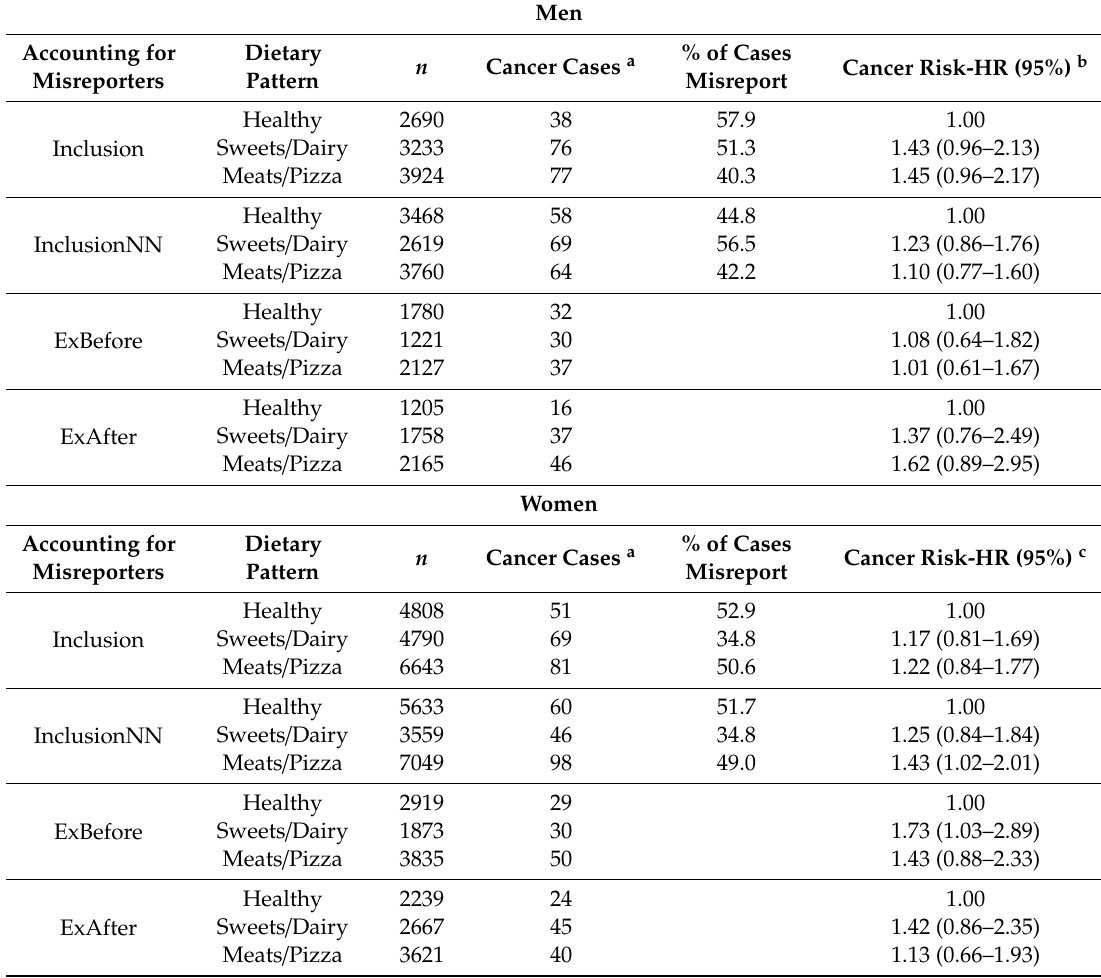
Table 6. Multivariable cox proportional hazards ratio of the incidence of Digestive-Cancers a stratified by four methods to account for